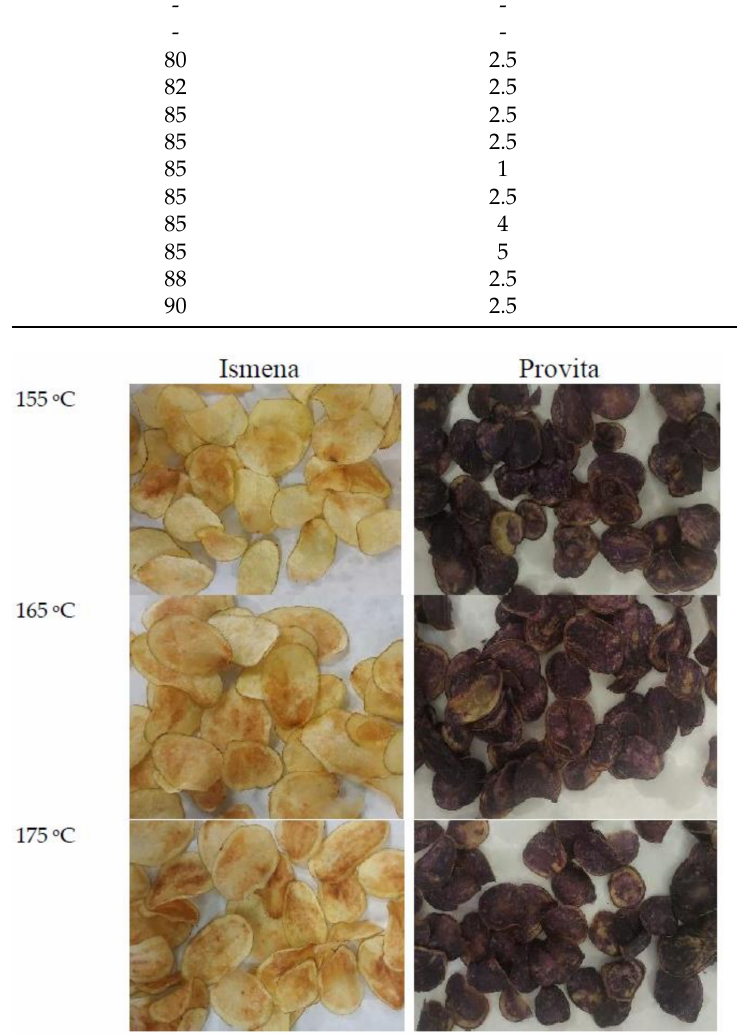
Figure 1. Potato crisps obtained without blanching, fried at different